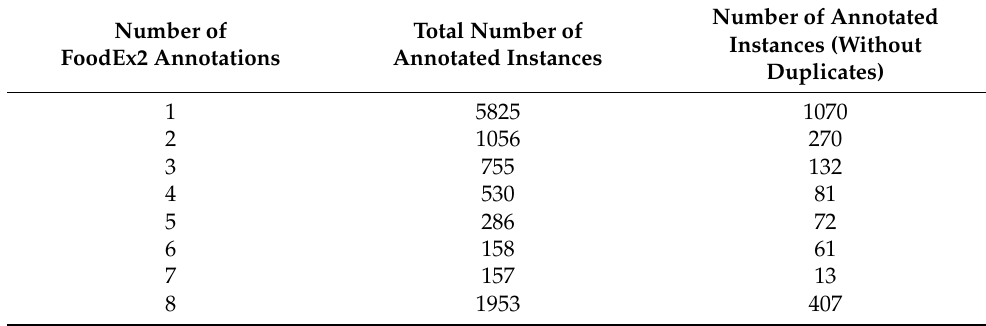
Table 2. Descriptive statistics about the FoodEx2 annotations on the FoodBase